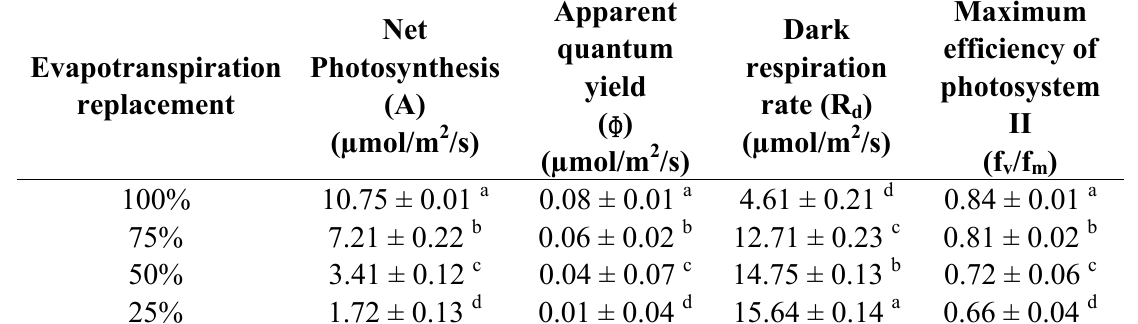
/f ) under different v m